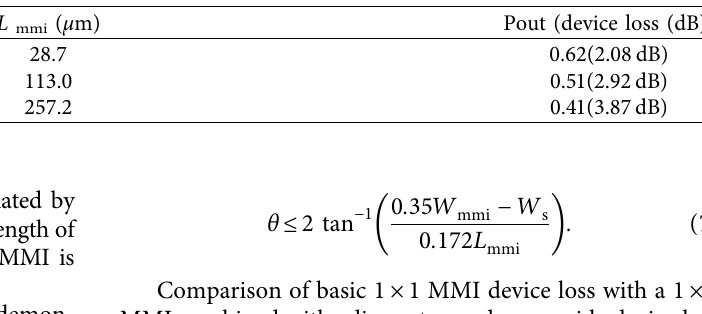
Table 1: A basic 1 × 1 MMI device